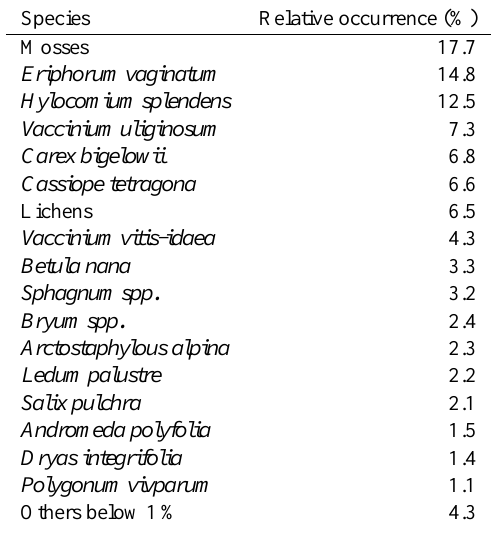
Table 1. Relative occurrence of species in the static